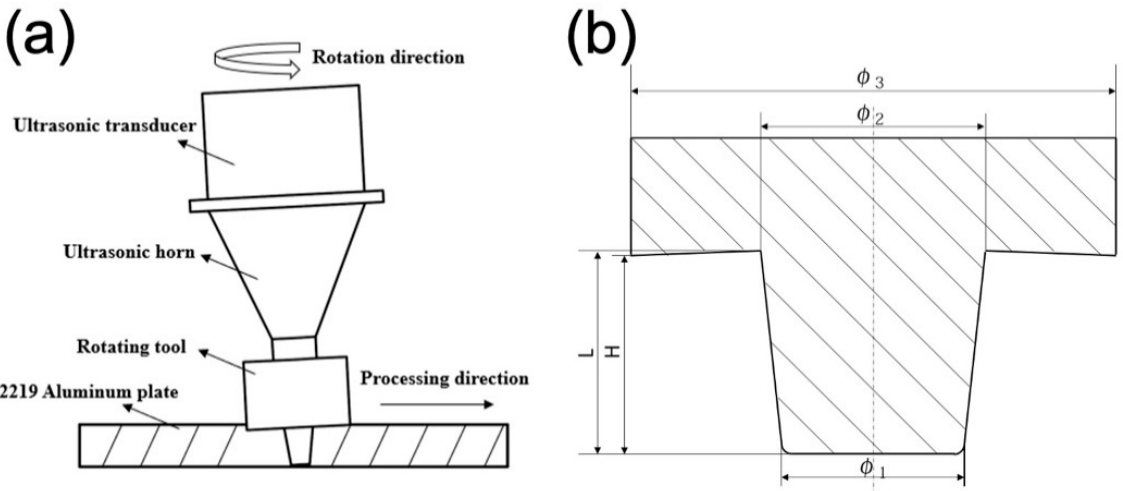
Figure 3. ( a ) Schematic diagram of ultrasonic-assisted friction stir welding stirring tool; ( b ) Shape and size of stirring tool (mm).